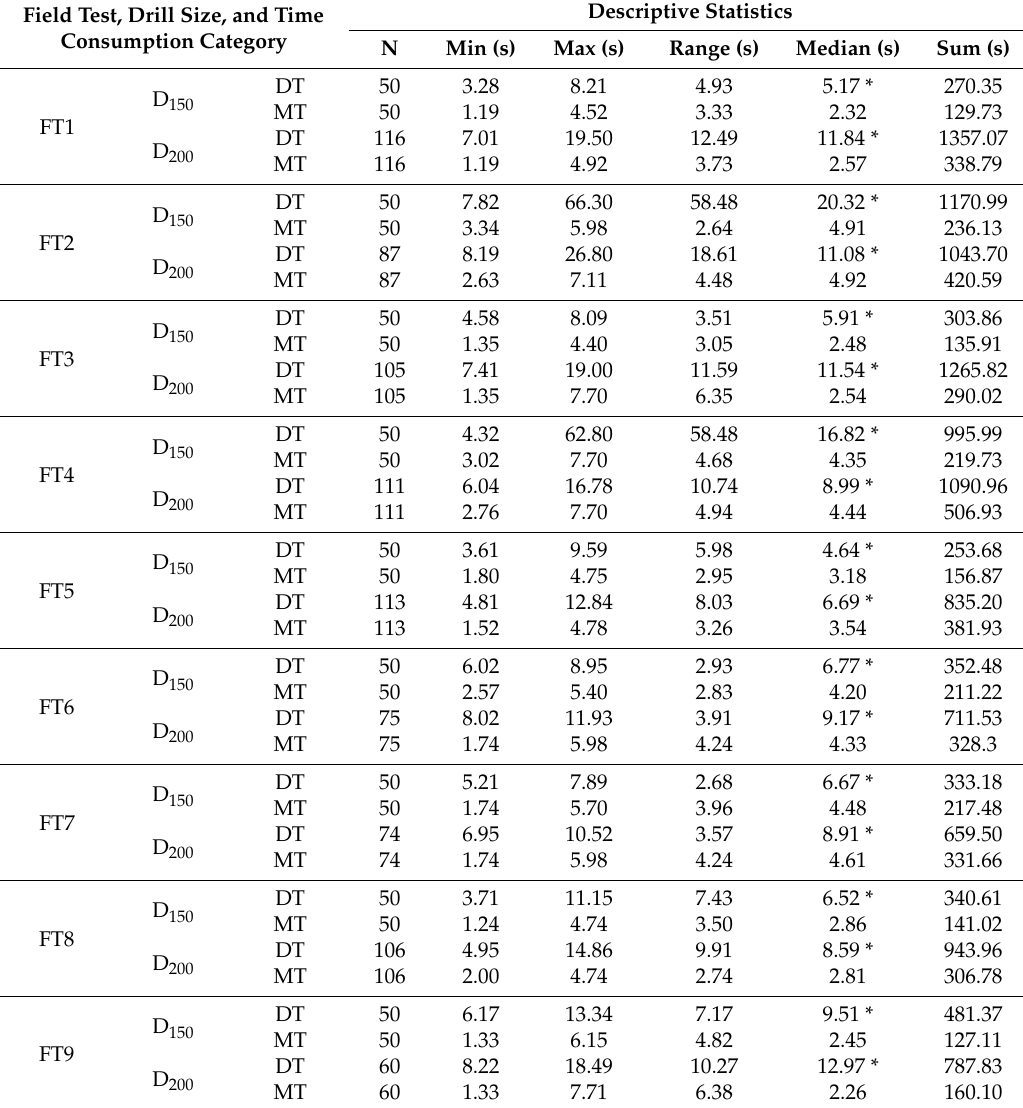
Table 3. Descriptive statistics of effective drilling (DT) and moving (MT)